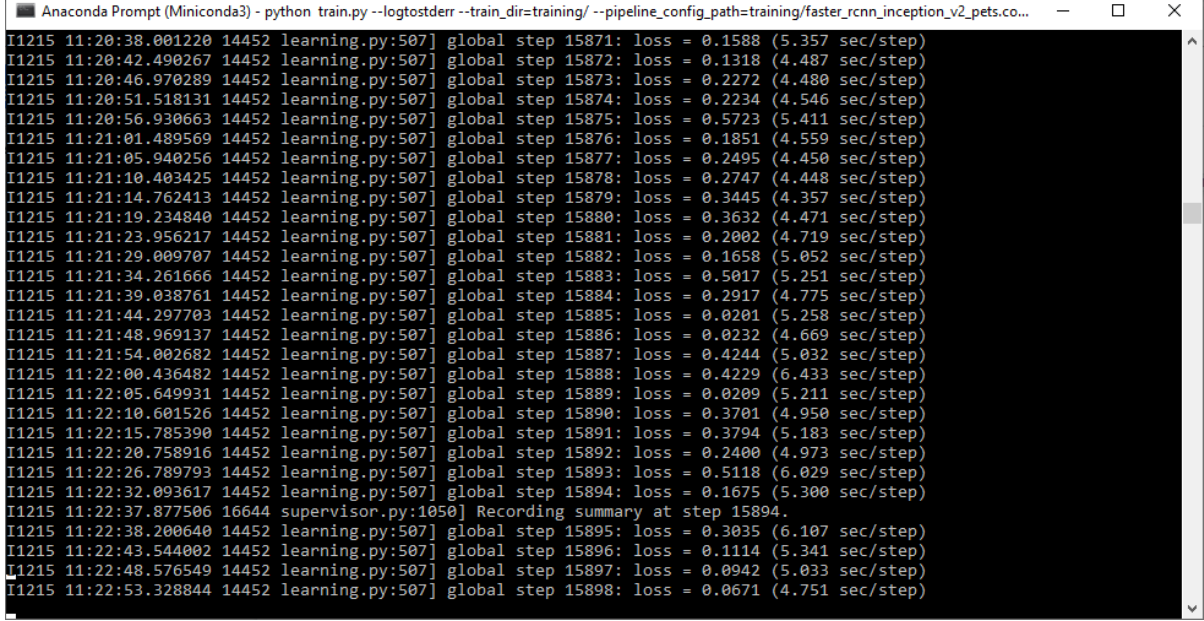
Figure 10. Image of Training by